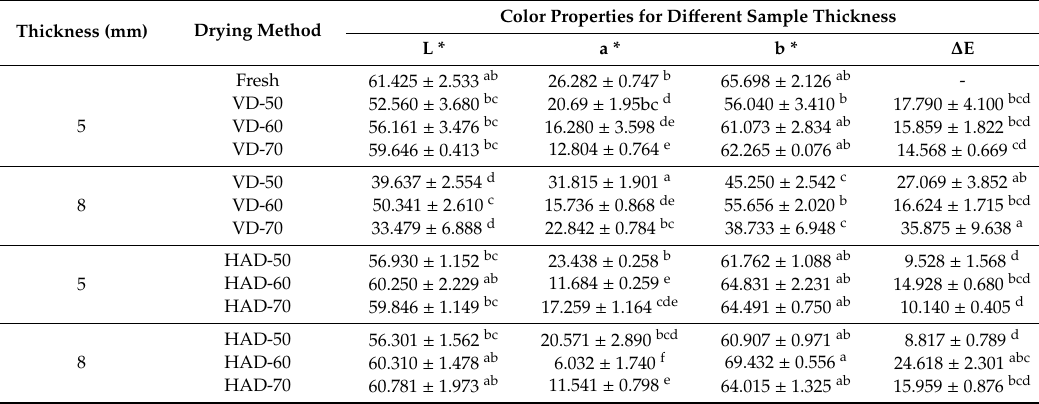
Table 15. Drying methods and color parameters of persimmon fruit